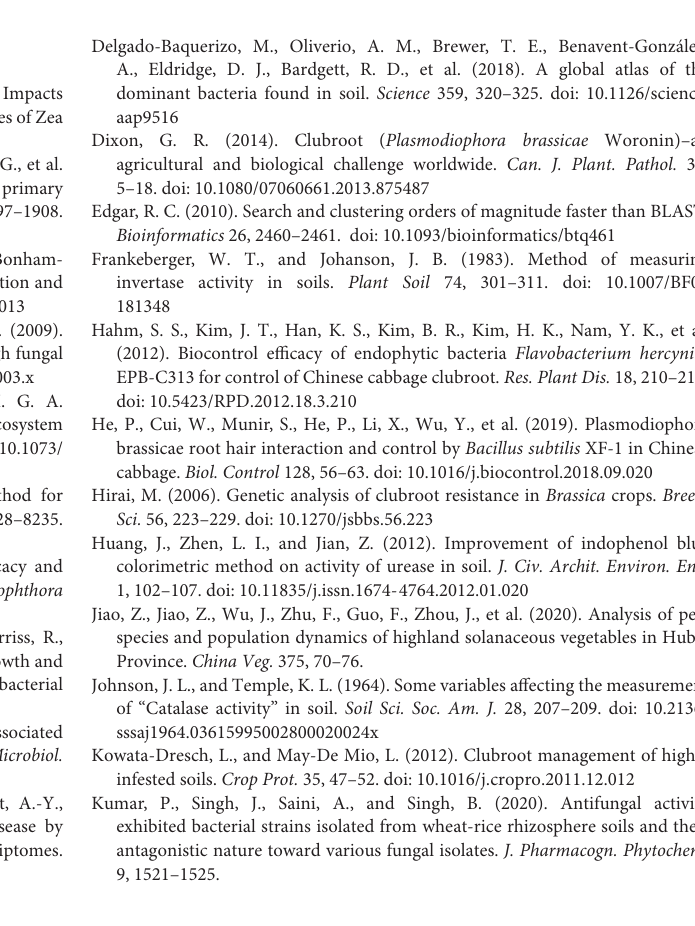
Supplementary Figure 1 | Correlations between soil physicochemical factors and genus of microbial community. Supplementary Table 1 | Primers used for quantitative real-time